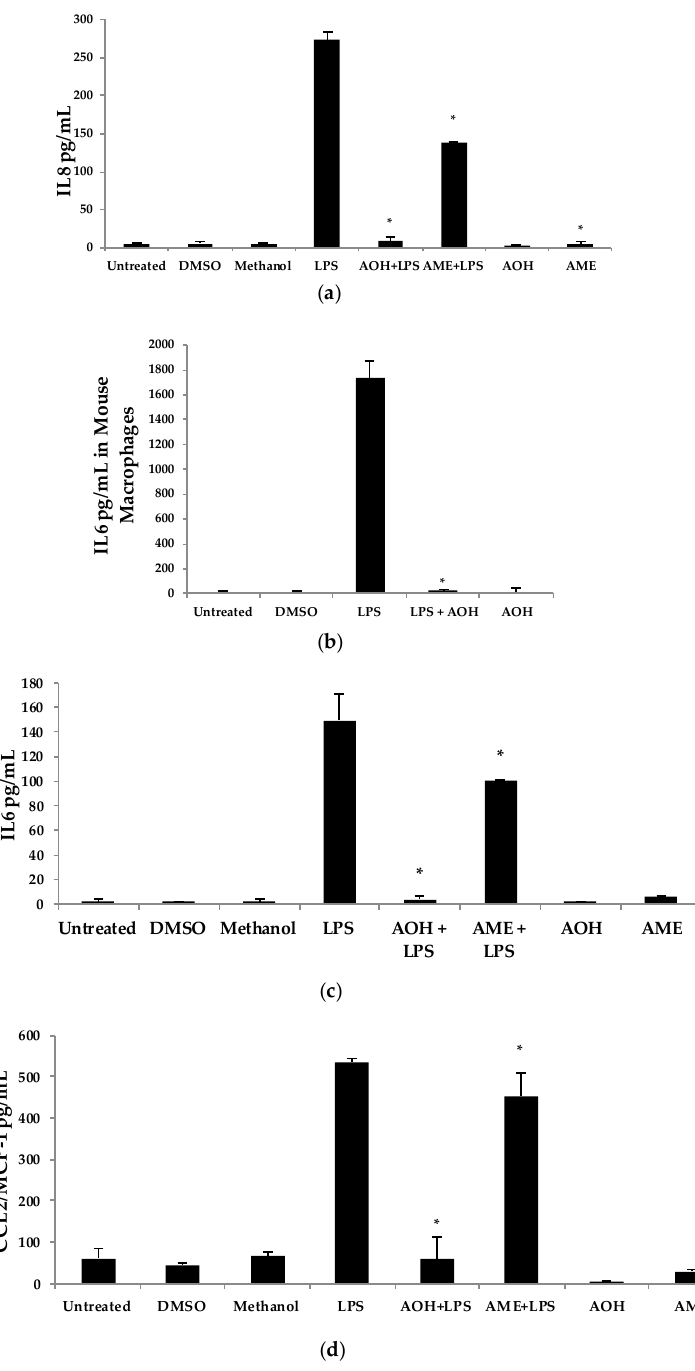
Figure 2. Alternariol (AOH) and alternariol monomethyl ether (AME) suppress lipopolysaccharide (LPS)-induced innate immunity. BEAS-2B airway epithelial cells (panels a, c, and d) and RAW 264.7 mouse macrophages (panel b) at a density of 5 × 10 5 cells/well were treated with 10 μ M of AOH and 10 μ M of AME in the presence and absence of 10 μ g of LPS and incubated for 24 h under normal conditions at 37 °C, 5% CO 2 . Supernatants were subsequently analyzed using enzyme-linked immunosorbent assay (ELISA) ( a ) IL8 BEAS-2B cells, ( b ) IL6 in RAW264.7 cells, ( c ) IL6 BEAS-2B cells, and ( d ) CCL2/MCP-1 BEAS-2B cells. An * indicates p < 0.05 according to Student’s t -test when comparing AOH/AME + LPS to LPS-induced controls. DMSO, dimethyl sulfoxide.